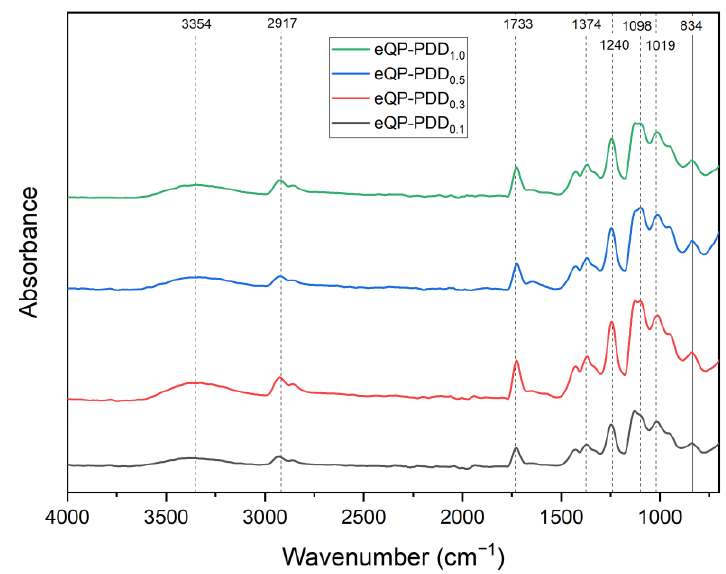
Figure 4. IR spectra of eQP-PDDx AEMs.